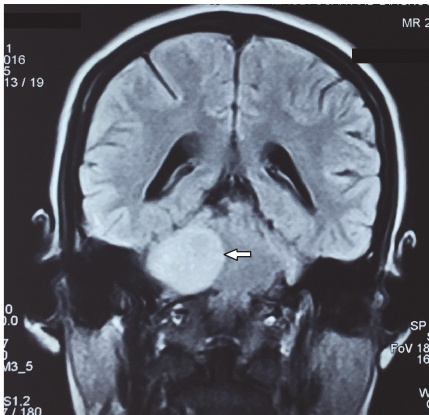
Figure 2: Contrast coronal MRI shows well-defined heteroge- neously enhancing T1 hypo and T2 predominantly hyperintense lesion in the right cerebellopontine angle (white